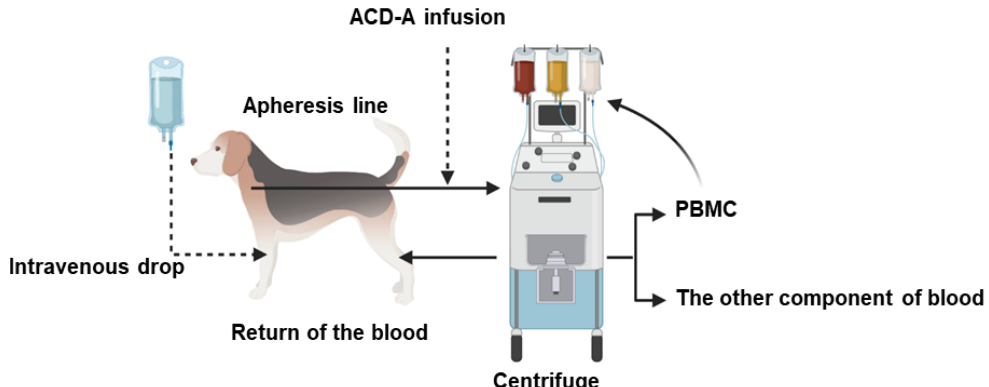
Figure 1. The procedure of apheresis in dogs. Blood was removed from the jugular vein and returned to the lateral saphenous vein. The peripheral blood mononuclear cells (PBMCs) obtained by apheresis were collected in a collection bag. During the procedure, ACD-A, saline, dopamine, and calcium gluconate were given intravenously.